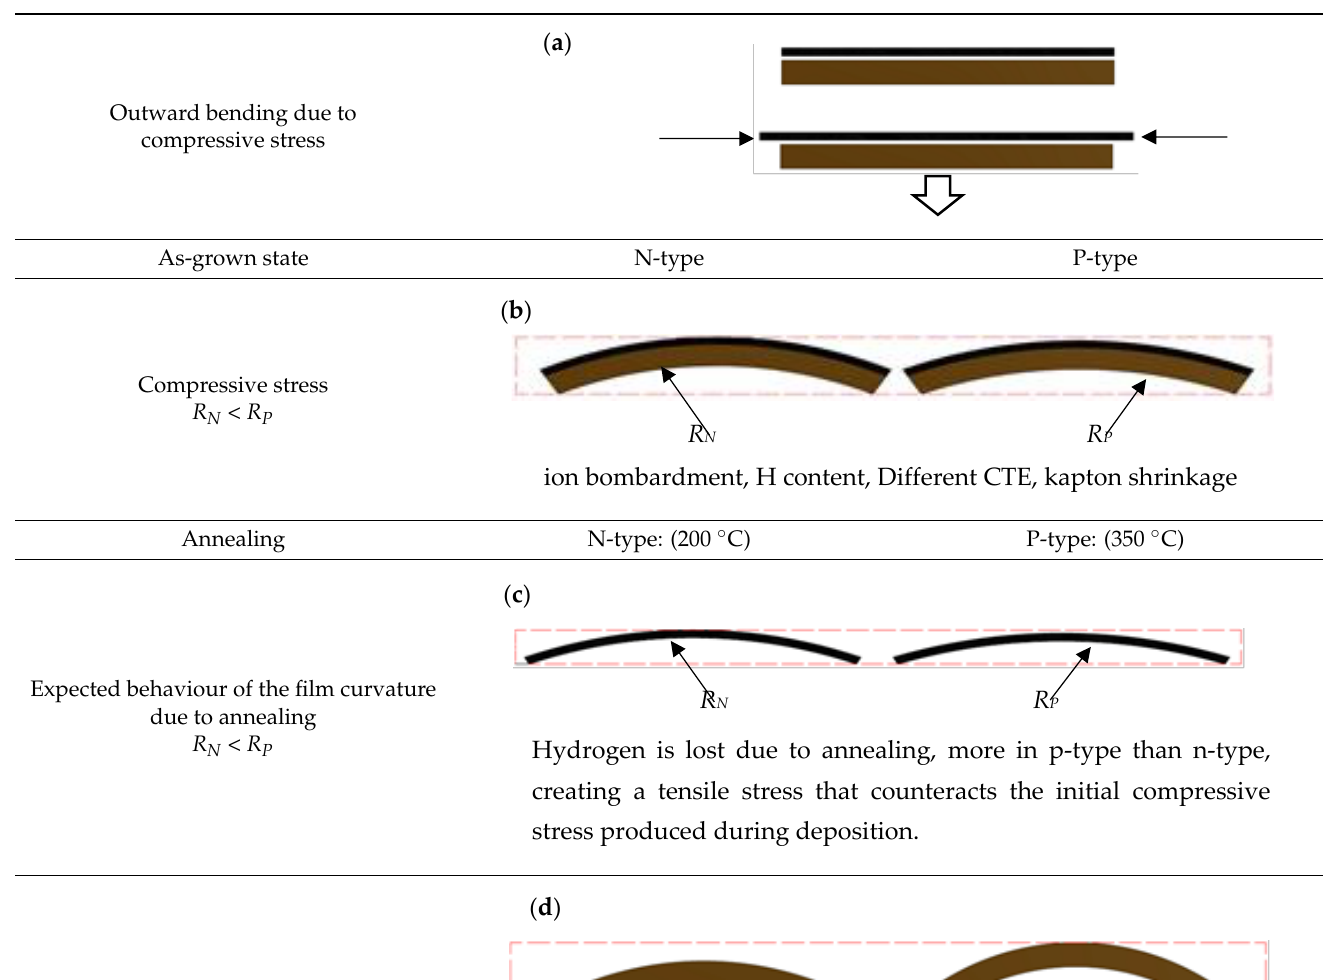
Table 2. Bending steps of the film/substrate system produced by the stress/strain created during deposition and optimisation process. Different curvatures were found depending on the doping type, and annealing conditions. R N and R P represent the radius of curvature of the n- and p-type sample, respectively, and the curvature is determined as the inverse of the radius ( 1 / R ).